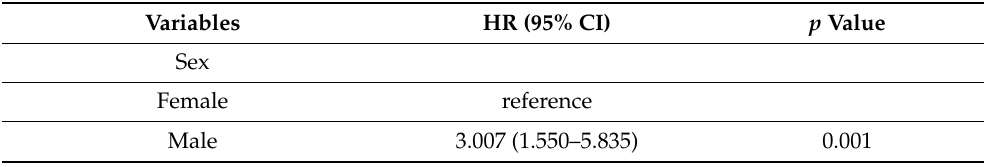
Table 3. Univariate Cox proportional hazard analysis for predicting recurrence in patients with N1b papillary thyroid